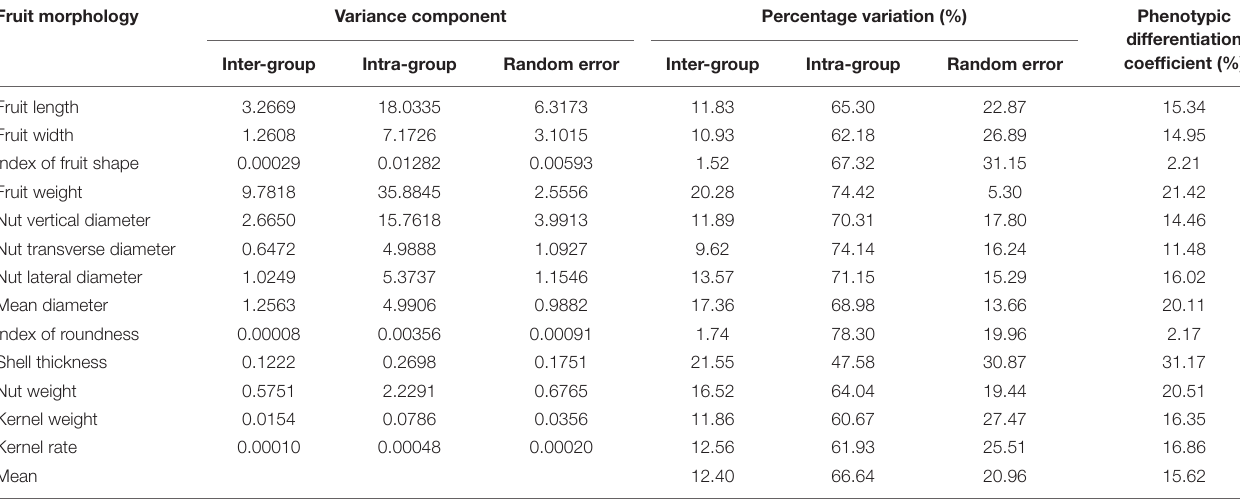
TABLE 2 | Variance component and phenotypic differentiation coefficient by fruit morphology. Fruit